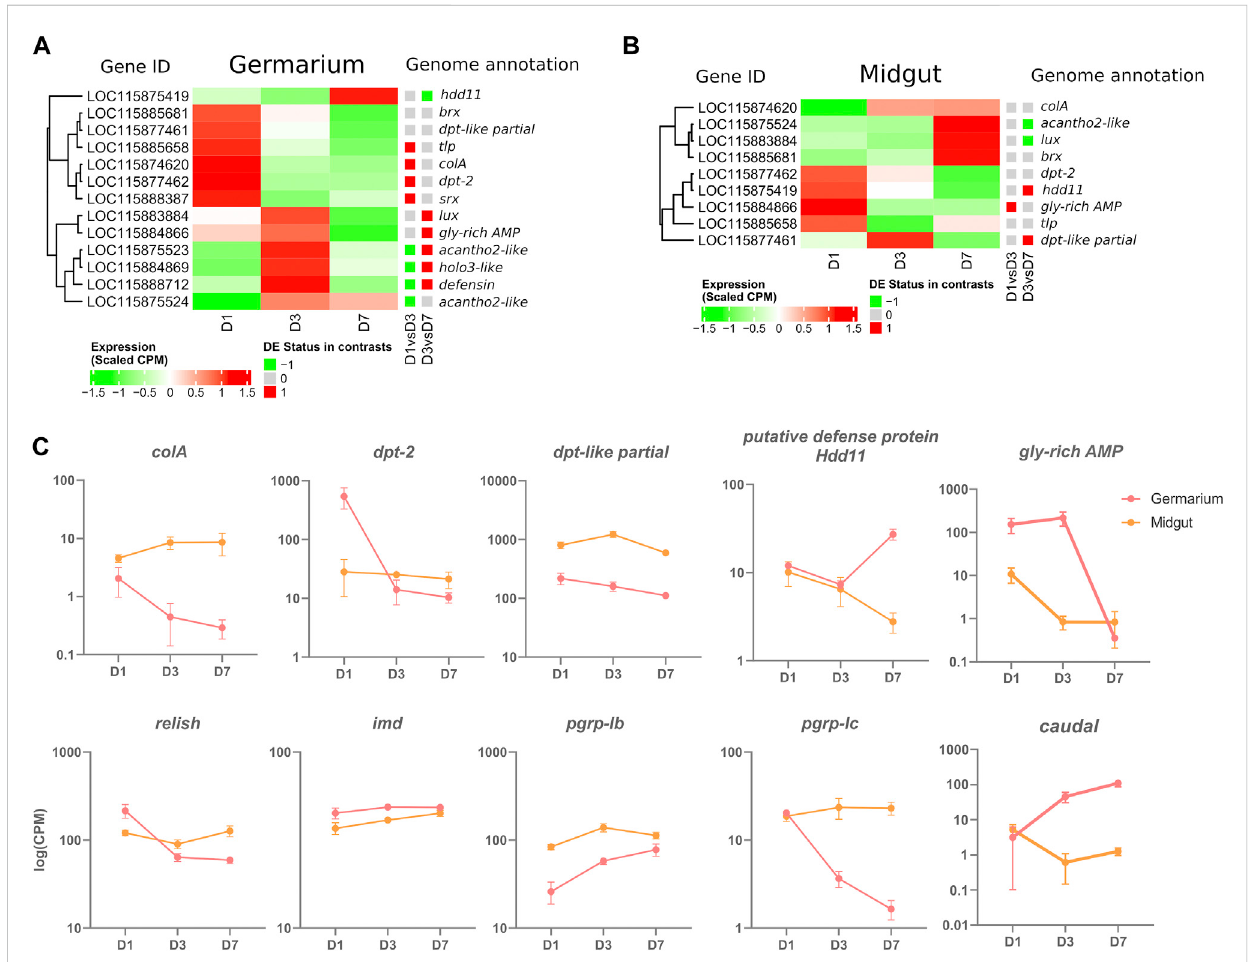
Immune-gene-centered analysis in the germarium and midguts of D1, D3, and D7 adults. (A) Heatmap of scaled CPM expression of AMPs in germarium (A) and midgut (B) Differentially expressed status between D1 and D3, and D3 and D7 is depicted with a coloured squared (red upregulation, green downregulation). (C) Examples of genes expressed at speci fi c time points in midgut and germarium. Log of Normalized CPM are